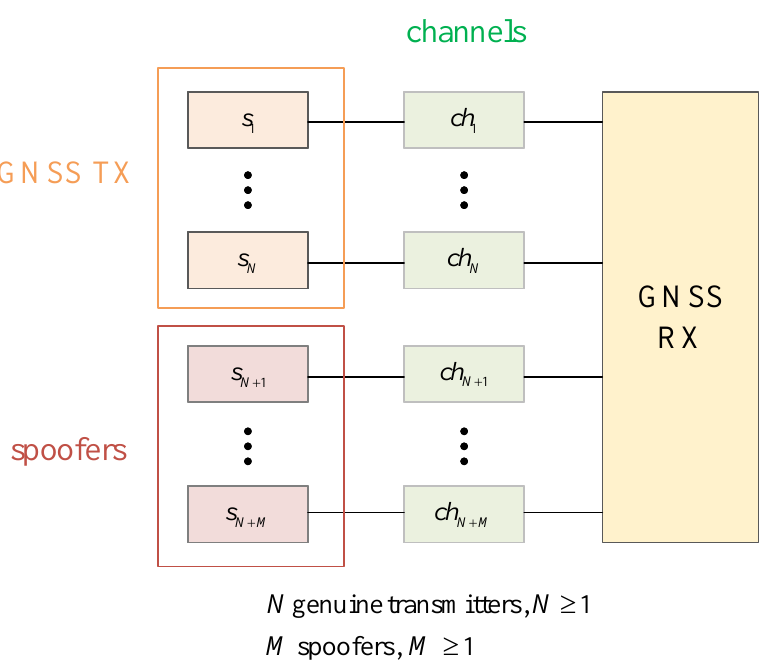
Figure 8. The illustration of the EVM principle. The blue arrow denotes the transmitted symbol, the yellow arrow denotes the received symbol, the blue arrow denotes the estimate, and the crimson arrow denotes the estimation